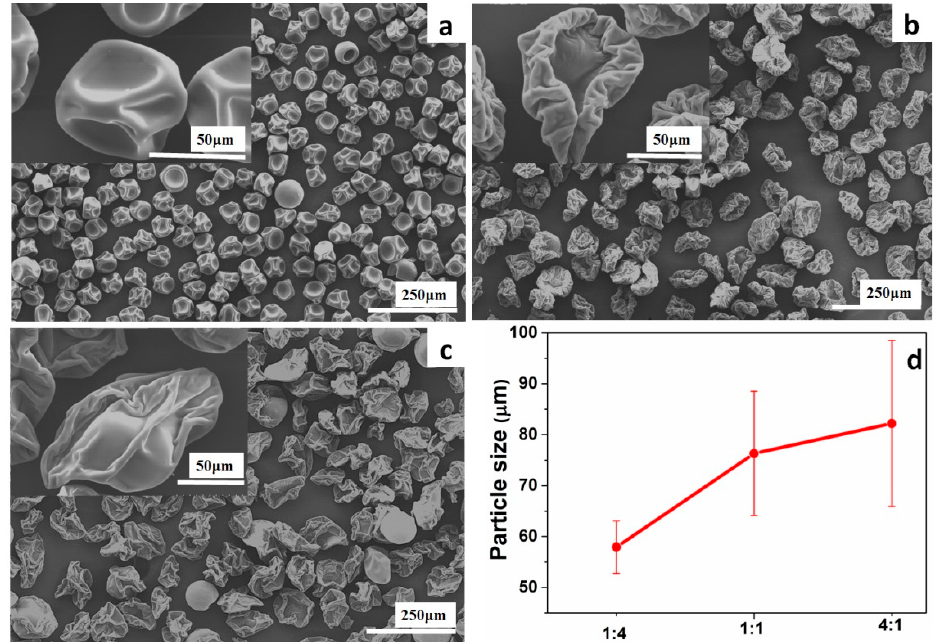
Figure 1. SEM images of the hydrocortisone-loaded microparticles obtained at a drying temperature of 155 °C with an ethanol/water mixed solvent of 1:4 ( a ); 1:1 ( b ); and 4:1 ( c ) volume ratio, respectively; and the particle size variation trend ( d ) with increasing ethanol/water volume ratio.